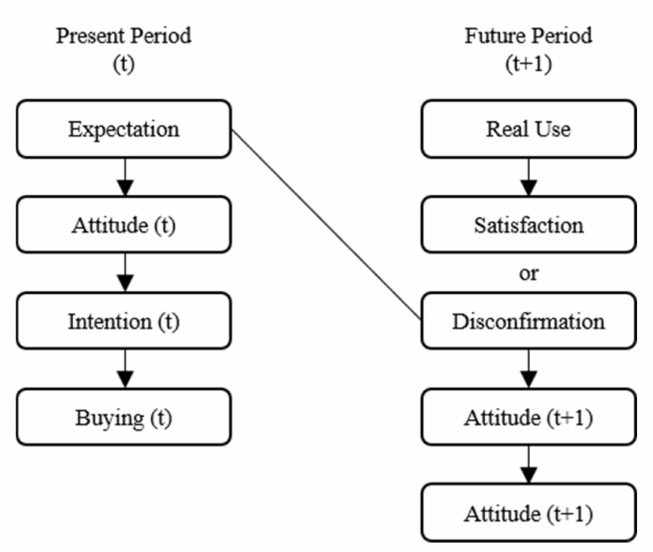
Figure 4. Consumer satisfaction process by time